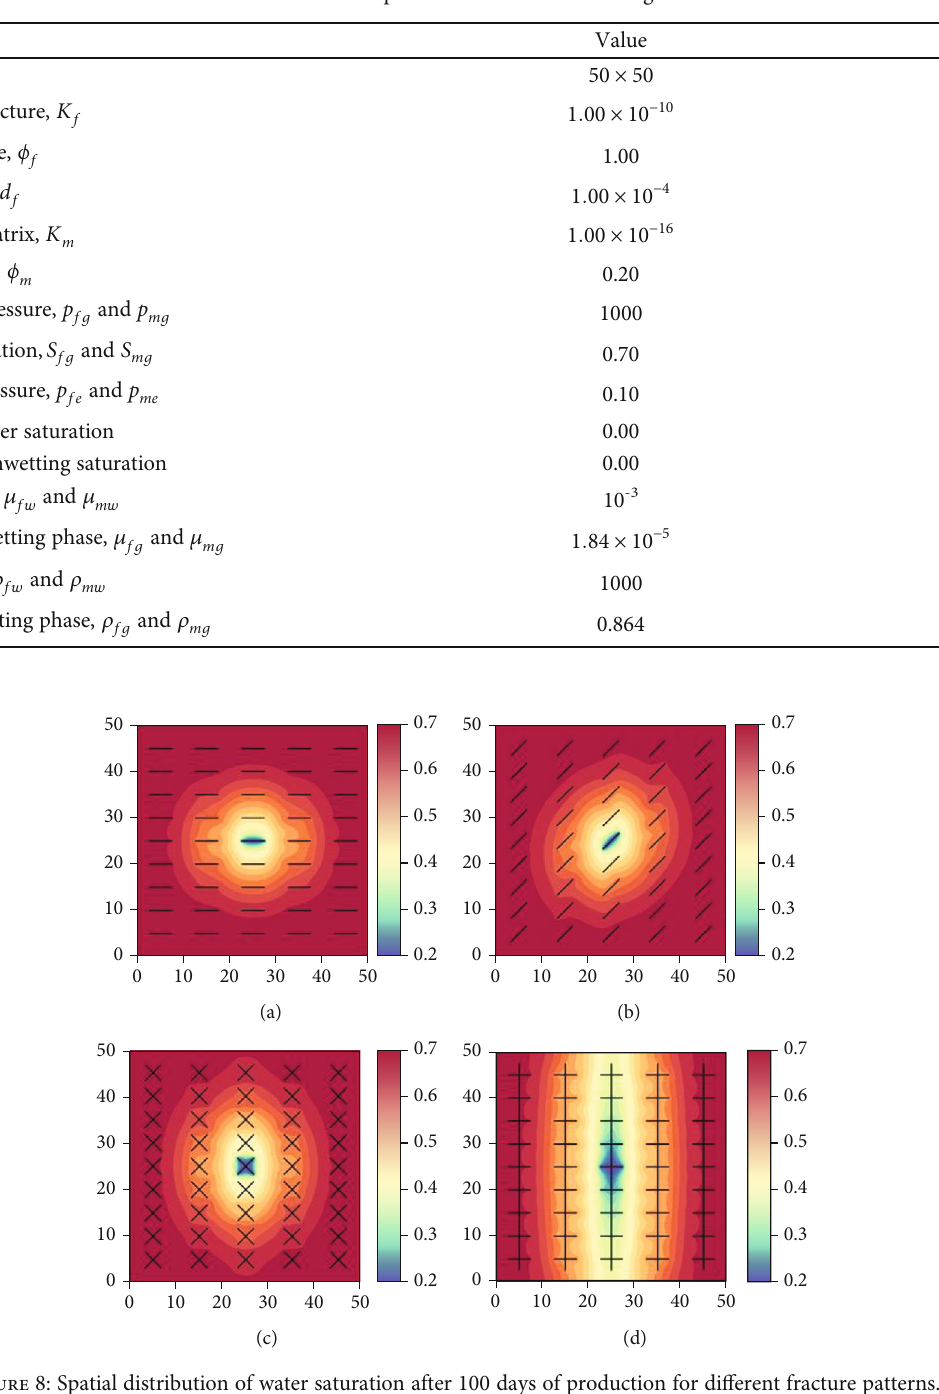
Table 1: Simulation parameters for water- fl ooding cases.